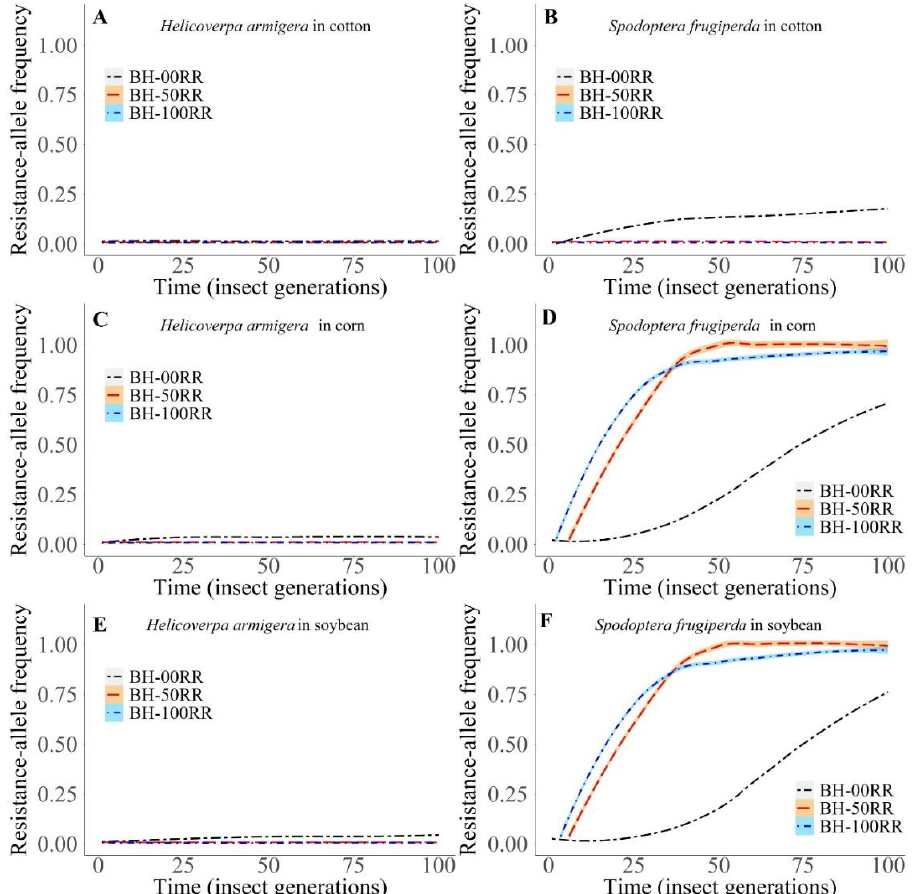
Figure 7. Absolute frequency of Spodoptera frugiperda and Helicoverpa armigera strains in intraspecific competition in cotton, corn, and soybean plants in the following scenarios: BH 00RR, competition behavior of the heterozygote 100% equal to the susceptible ones; BH 50RR, competition behavior of the intermediate heterozygote, i.e., 50%, equal to the susceptible and 50% equal to the resistant individuals, BH 100RR, competition behavior of the heterozygote, 100% equal to the resistant ones. ( A ) H. armigera in cotton. ( B ) S. frugiperda in cotton. ( C ) H. armigera in corn. ( D ) S. frugiperda in corn. ( E ) H. armigera in soybean. ( F ) S. frugiperda in soybean.